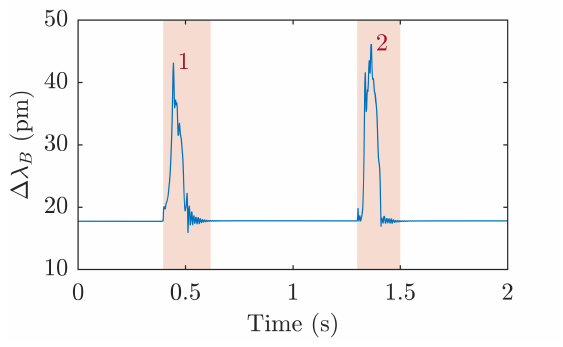
Figure 6. The response of a car crossing over a 50 kph speed sensor